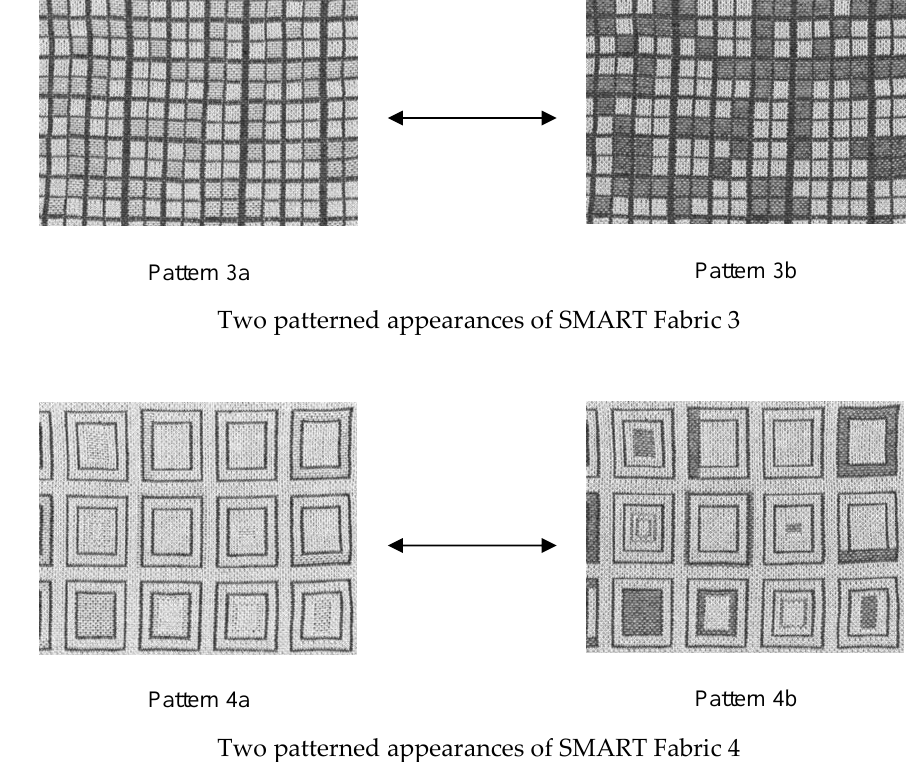
Figure 6. Four SMART pattern-changing fabrics investigated in current study.